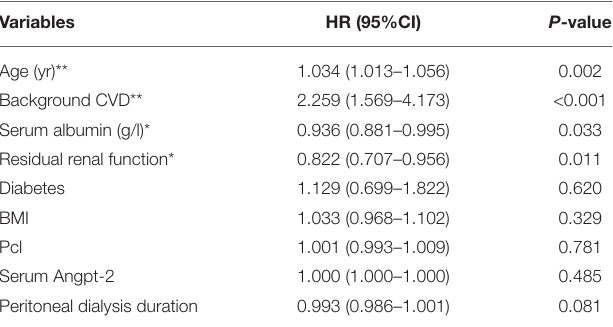
CVD, cardiovascular disease; BMI, body mass index; Pcl, peritoneal protein clearance; Angpt, angiopoietin. * p = 0.01–0.05; ** p < 0.01.